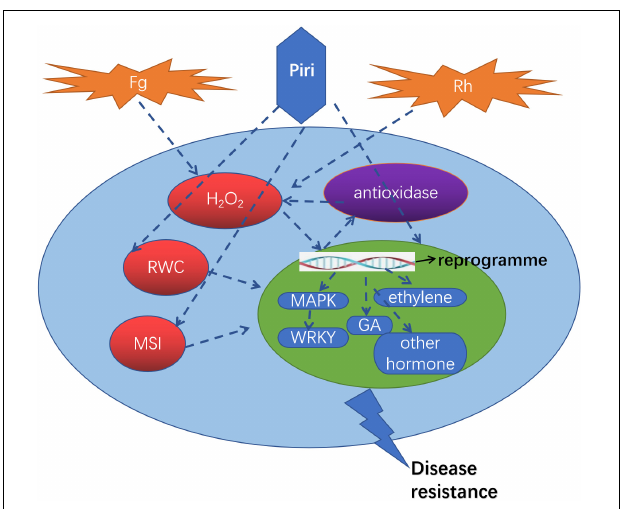
FIGURE 9 | A proposed model illustrating the roles of P. indica in wheat against R. cerealis and F. graminearum. Piri, P. indica ; Fg, F. graminearum ; Rh, R. cerealis ; RWC, relative water content; MSI, membrane stability index; GA, gibberellin acid; MAPK, mitogen-activated protein kinases.